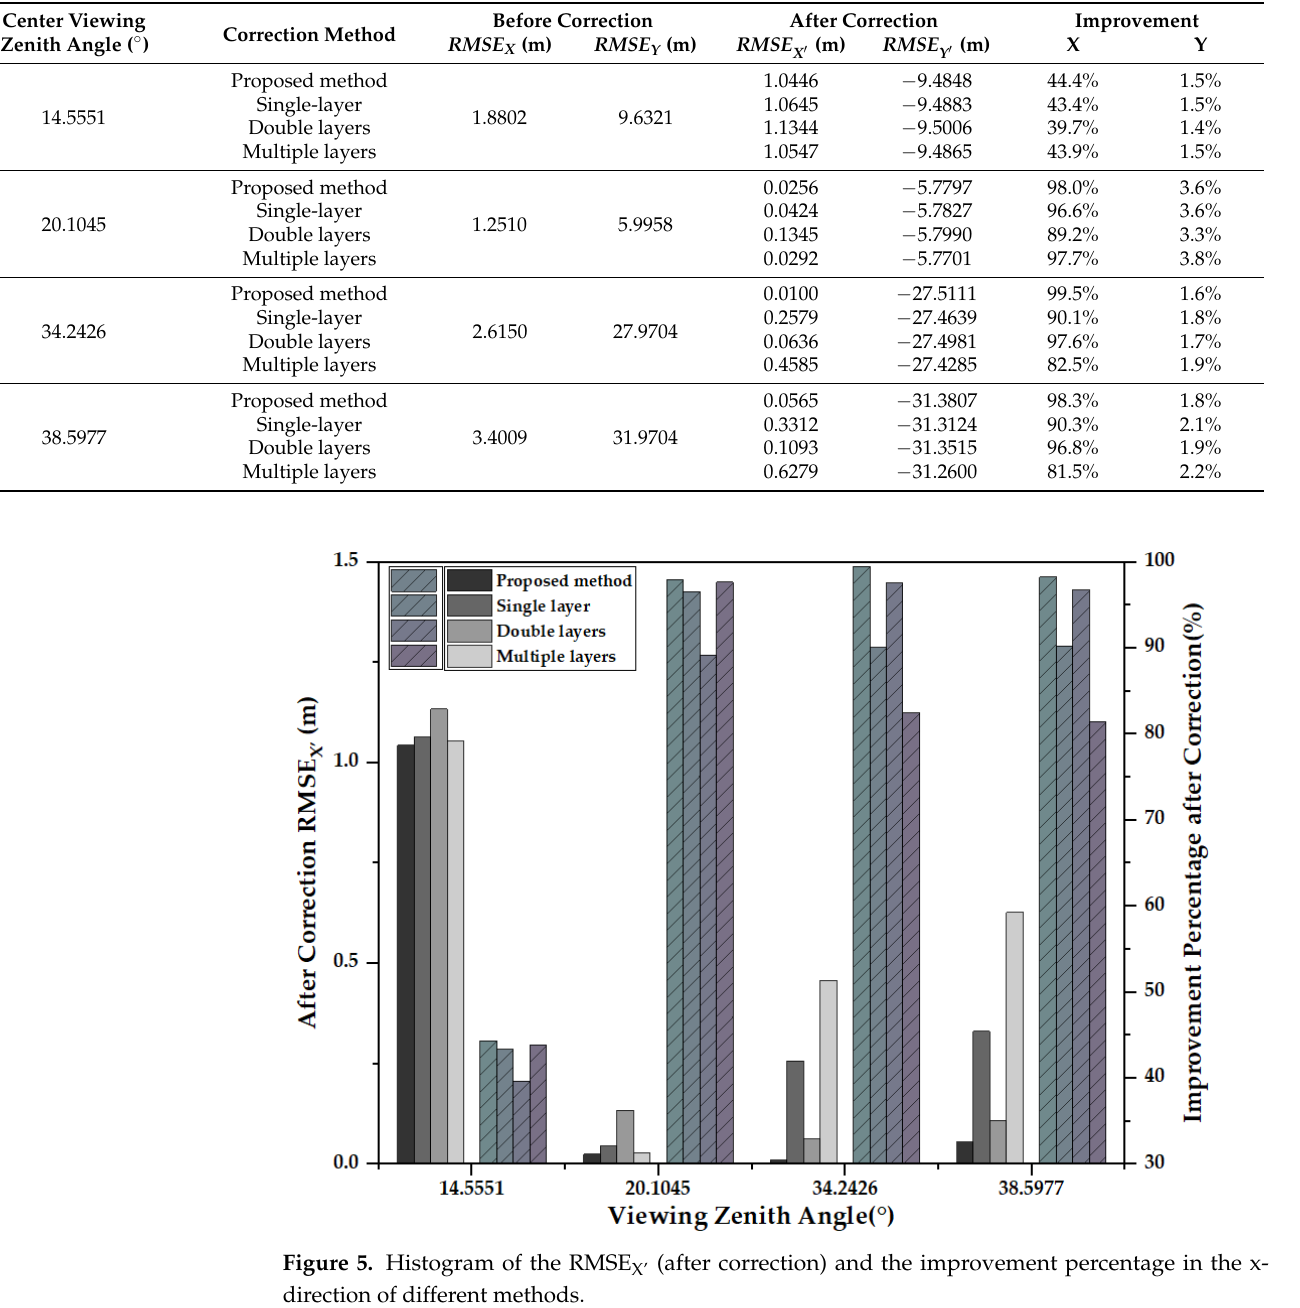
Table 5. Comparison with the state-of-the-art atmospheric refraction correction methods.